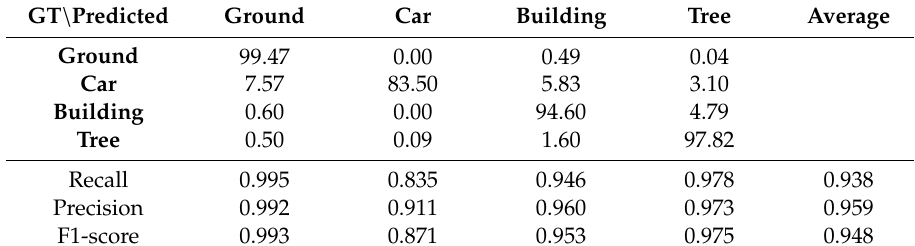
Table 10. Normalized Confusion matrix of ALS_PointNet_4 (%).